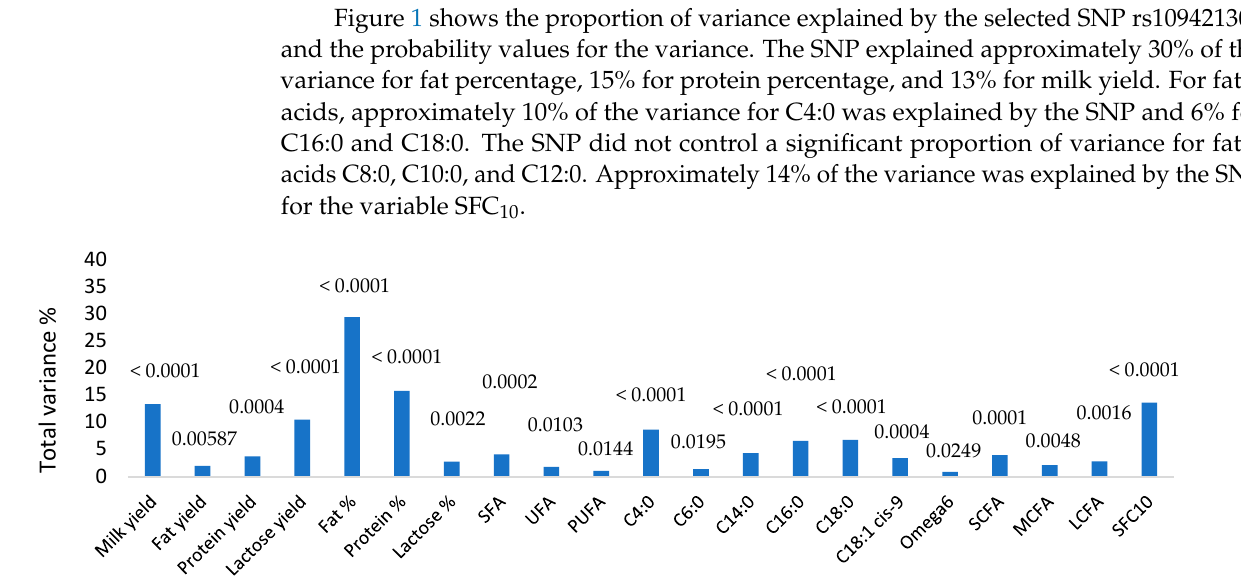
Figure 1. The proportions of variance explained by the SNP rs109421300 for the production traits and composition traits in cows milked in the milking season 2020-2021. SFA = Saturated fatty acids; UFA = Unsaturated fatty acids; PUFA = Polyunsaturated fatty acids; SCFA = Short-chain fatty acids (sum of C4:0, C6:0, and C8:0); MCFA = Medium-chain fatty acids (sum of C10:0, C12:0); LCFA = Long-chain fatty acids (sum of C14:0, C16:0, C18:0 and C18:1 cis -9, and omega-6); SFC 10 = Solid fat content at 10 °C.